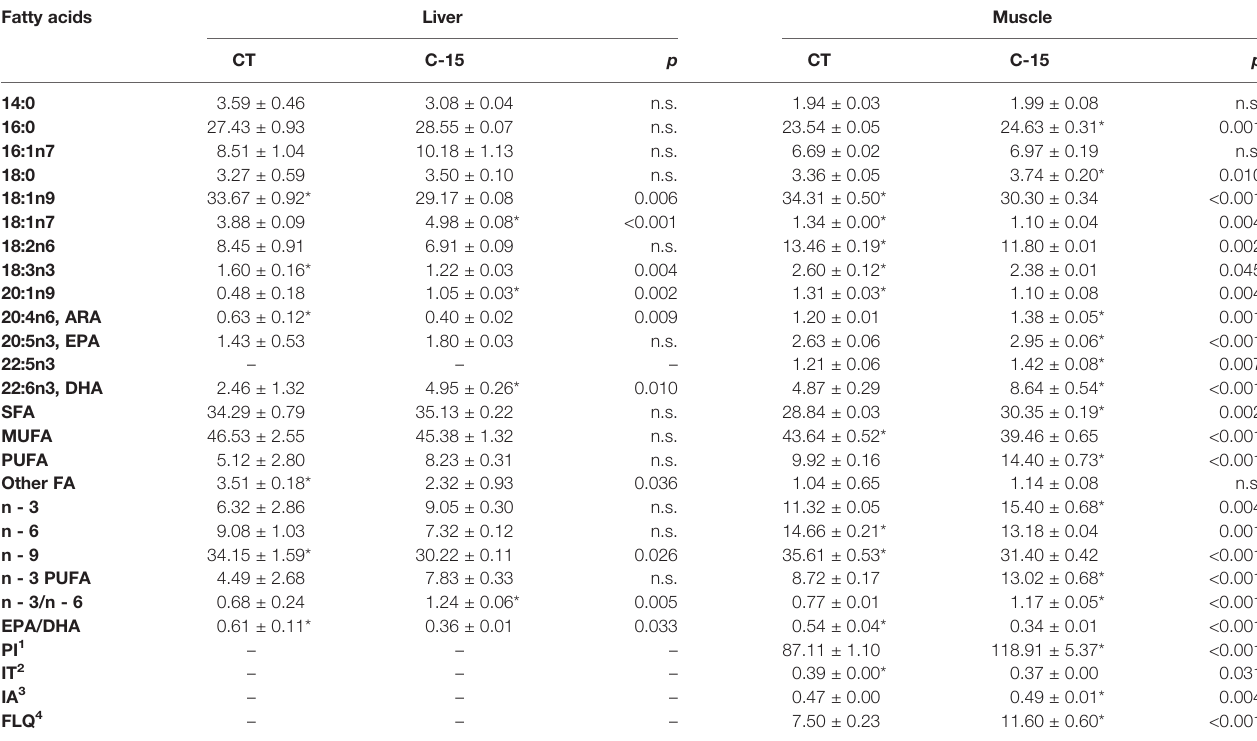
TABLE 5 | Liver and muscle fatty acid pro fi le (% of total fatty acids) of juvenile C. labrosus fed control (CT) and C-15 diets during 90 days. Fatty acids Liver Muscle CT C-15 p CT C-15 p